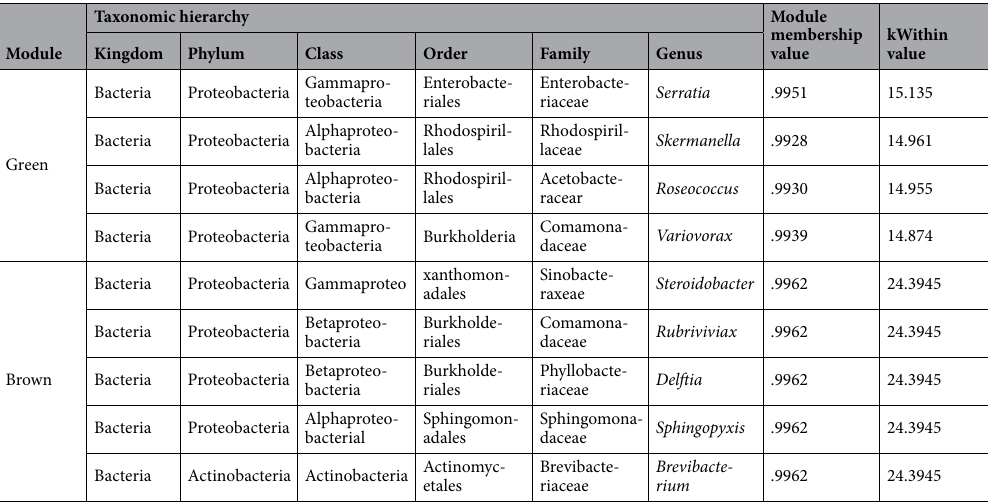
Table 5. Two of the eight WGCNA modules. Displayed modules expressed the highest value of eigengenes and best describe and denote module members showing positive correlations to co-occurring genera detected within the same module. The green module indicates taxa within Trichoplusia ni gut communities after being fed with A. thaliana leaves. The brown module indicates taxa within Trichoplusia ni gut communities after being fed with Solanum lycopersicum